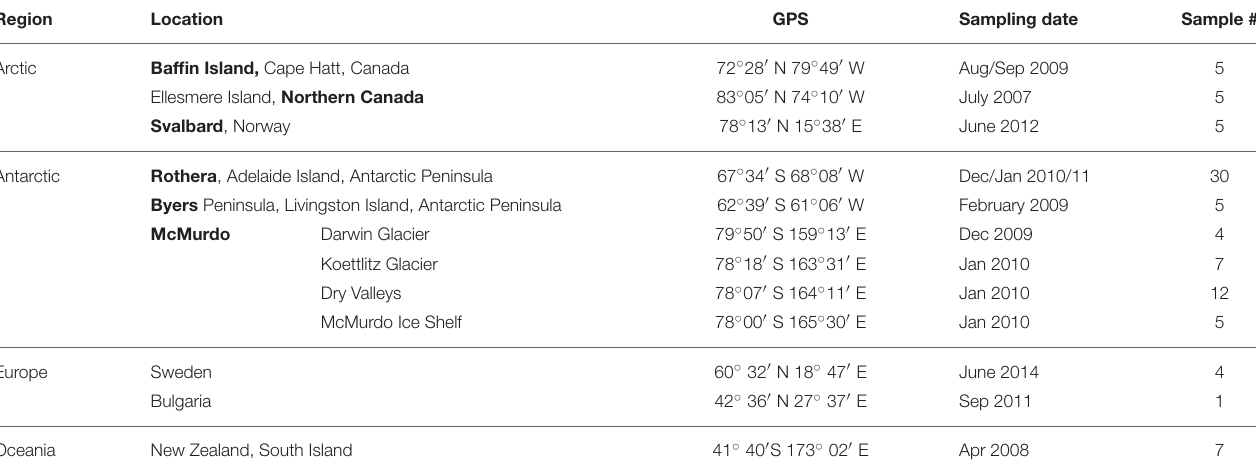
TABLE 1 | Sampling sites, dates and number of samples.